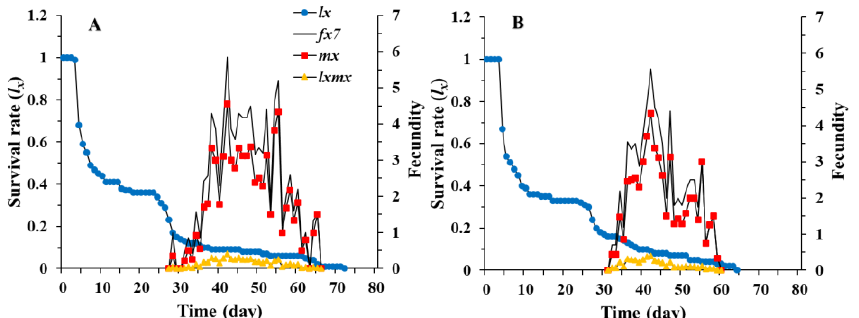
Figure 2. Age-specific survival rate ( lx ), age-stage specific fecundity ( f x 7 ) of the female stage, age- specific fecundity ( mx ) of Chrysopa pallens ever cultured on Megoura japonica ( A ) and Corcyra cephalonica eggs ( B ) under fluctuating temperature conditions in a greenhouse.